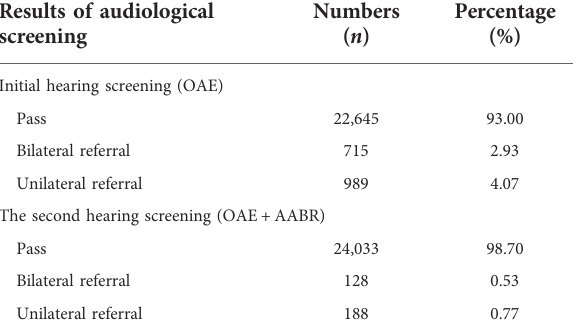
TABLE 4 Frequency of the genetic variants in common deafness genes in